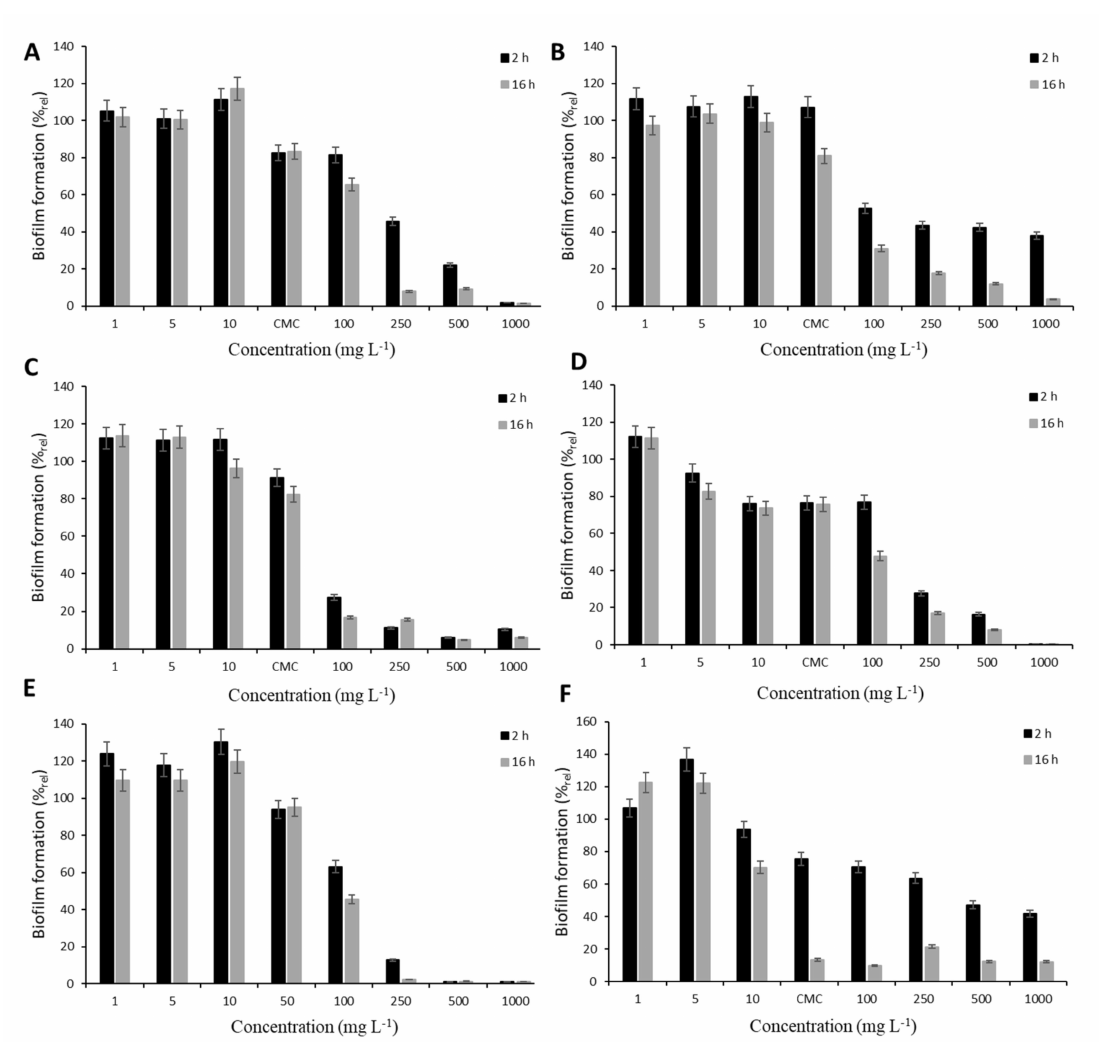
Figure 1. In relation to the diverse composition of rhamnolipid mixtures, different effects on biofilm formation were observed. At concentrations below CMC, no significant decrease in colonization was observed, either after 2 or 16 h. The only exception was detected after biofilm exposition to rh3777. Decreases of almost 10% and 20% after 2 and 16 h, respectively, in colonization were observed after treatment by 5 mg L − 1 . In all cases, the application of rhamnolipids at their CMC led to the restriction of biofilm formation. The highest decrease was elicited by rh3777 (almost 26%). Concentrations higher than CMC subsequently resulted in significant inhibition of biofilm formation. Rhamnolipid rh3776 affected T. cutaneum colonization the most; 100 mg L − 1 elicited decreases of 73% and 83% after 2 and 16 h, respectively. Other rhamnolipids decreased colonization by only 20–50%. All tested rhamnolipids showed similar action to SDS. On the contrary, the behavior of Tween 80 was different. The efficacy after 2 h of exposure to CMC and higher concentrations was significantly lower than after 16 h treatment. Nevertheless, Tween 80 also proved the ability to restrict biofilm formation.